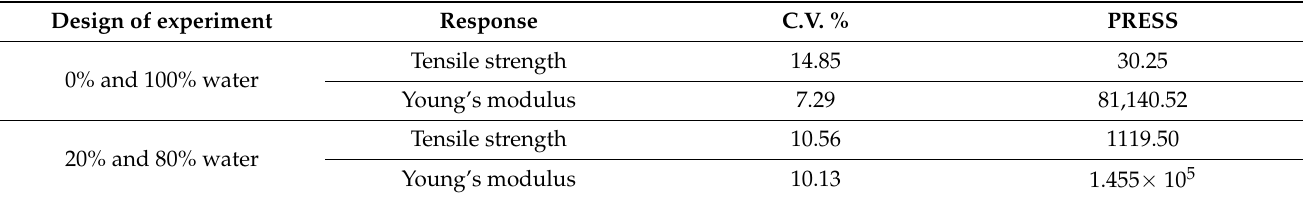
Table 10. The C.V. and PRESS values of the